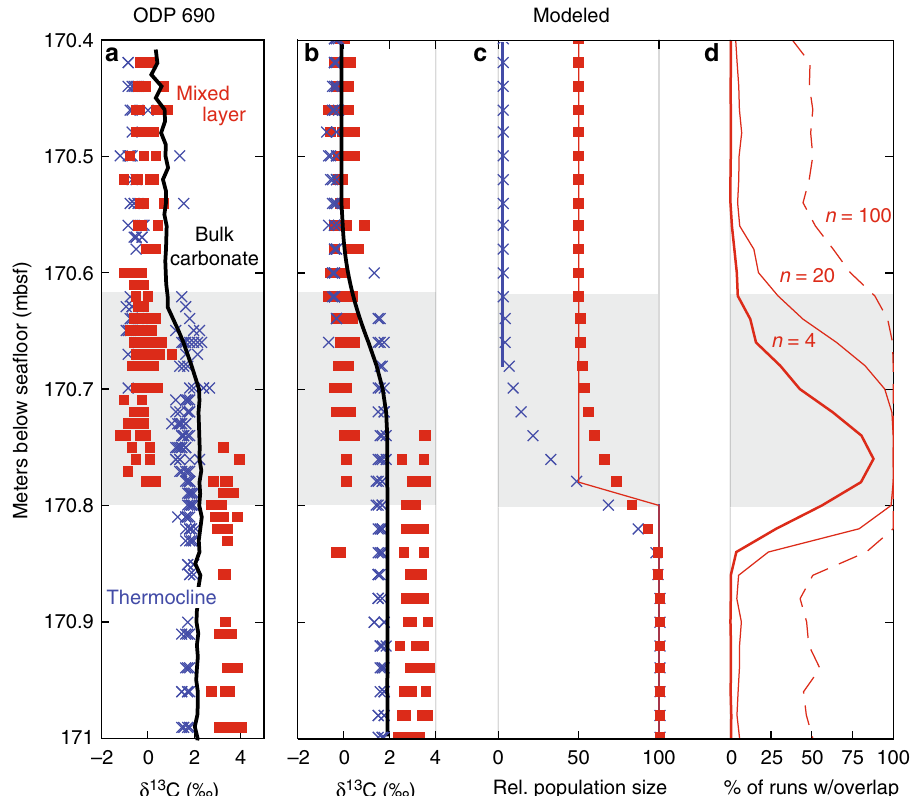
Fig. 4 Sediment-mixing model including unequal changes in abundance across mixed-layer and thermocline species can explain patterns in ODP Site 690 data. a Single-foraminifera isotope data from ODP Site 690 across the PETM from mixed-layer planktonic foraminifera δ 13 C ( red ), thermocline δ 13 C ( blue ), and from bulk carbonate δ 13 C ( black ) (values from ref. 8 ). b Sediment model simulation of δ 13 C in mixed-layer ( red ), thermocline ( blue ), and bulk carbonate ( black ) assuming a greater change in the abundance of thermocline species and in the nannoplankton taxa comprising the majority of the bulk carbonate than in mixed-layer species, with abundance changes indicated in panel c where lines = pre-mixing abundance and symbols = post-mixing abundance. The modeled onset of the CIE in the unmixed record occurs in all groups simultaneously at 170.8 mbsf — it is the combination of bioturbation and unequal abundance change that makes the δ 13 C change appear diachronous. d Despite bioturbation, most samples record just pre-event or CIE-type isotopic values when only small sample sizes ( n = 4 individuals) are selected from the model record. Gray box highlights the interval in ODP Site 690 data showing the apparent delay in isotopic change between mixed layer and thermocline